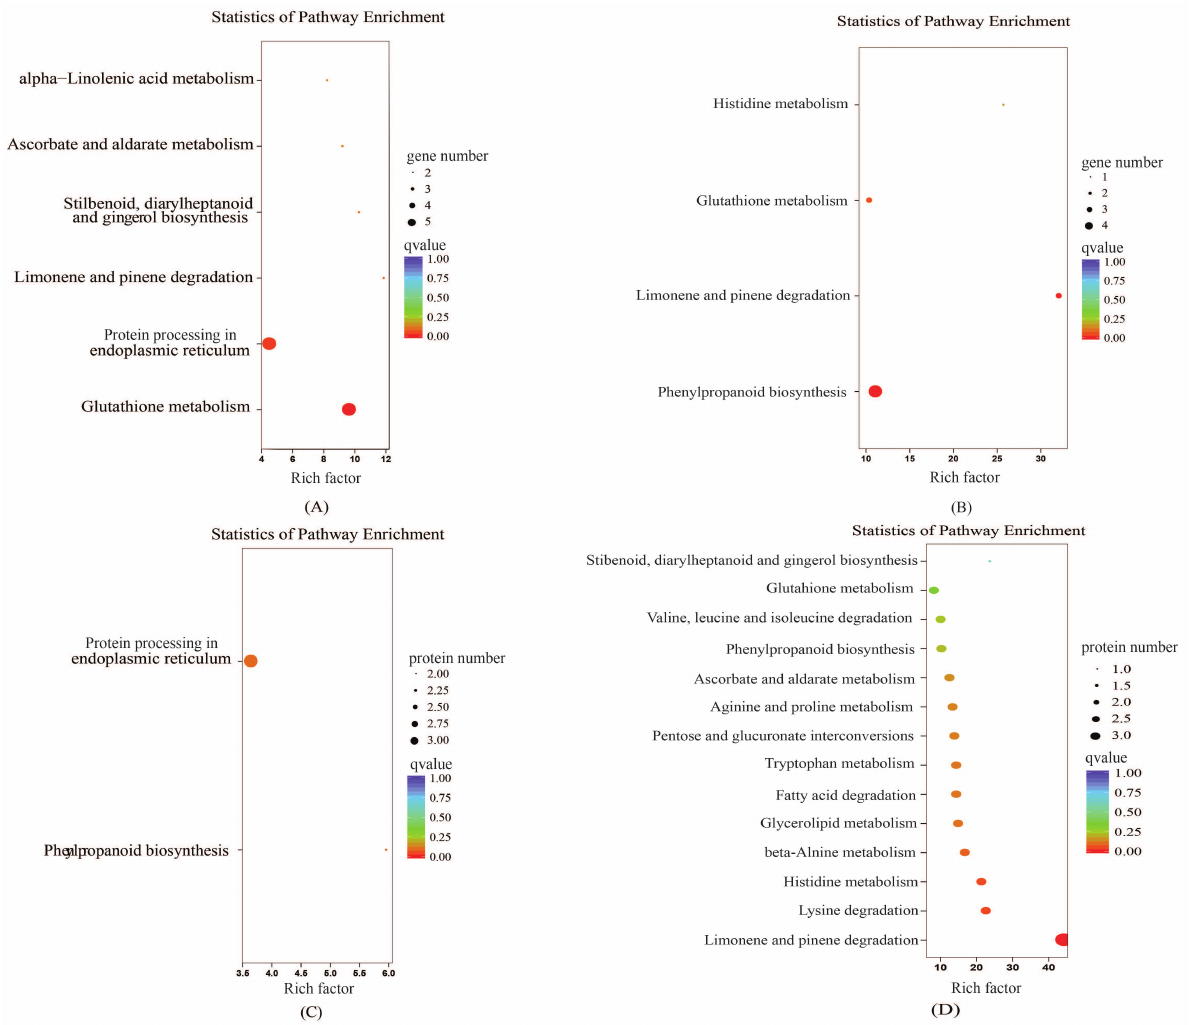
Figure 7. Kyoto Encyclopedia of Genes and Genomes (KEGG) enrichment analysis of the proteome and transcriptome data. ( A ) represents the expression trends of differentially expressed genes and proteins that are the same as that of the differentially expressed genes in the KEGG enrichment analysis. ( B ) represents the expression trends of differentially expressed genes and proteins that are opposite to that of the differentially expressed genes in the KEGG enrichment analysis. ( C ) represents the expression trends of differentially expressed genes and proteins that are the same as that of differentially abundant proteins in the KEGG enrichment analysis. ( D ) represents the expression trends of differentially expressed genes and proteins that are opposite to that of differentially abundant proteins in the KEGG enrichment analysis. Enrichment factor represents the ratio of genes annotated to the pathway of differential genes to the ratio of all genes annotated to the pathway. Enrichment factor indicates that the enrichment level of differential genes in the pathway is more significant. p -value after the correction for multiple hypothesis testing q -value is, the smaller the q -value represent a significant enrichment of the more